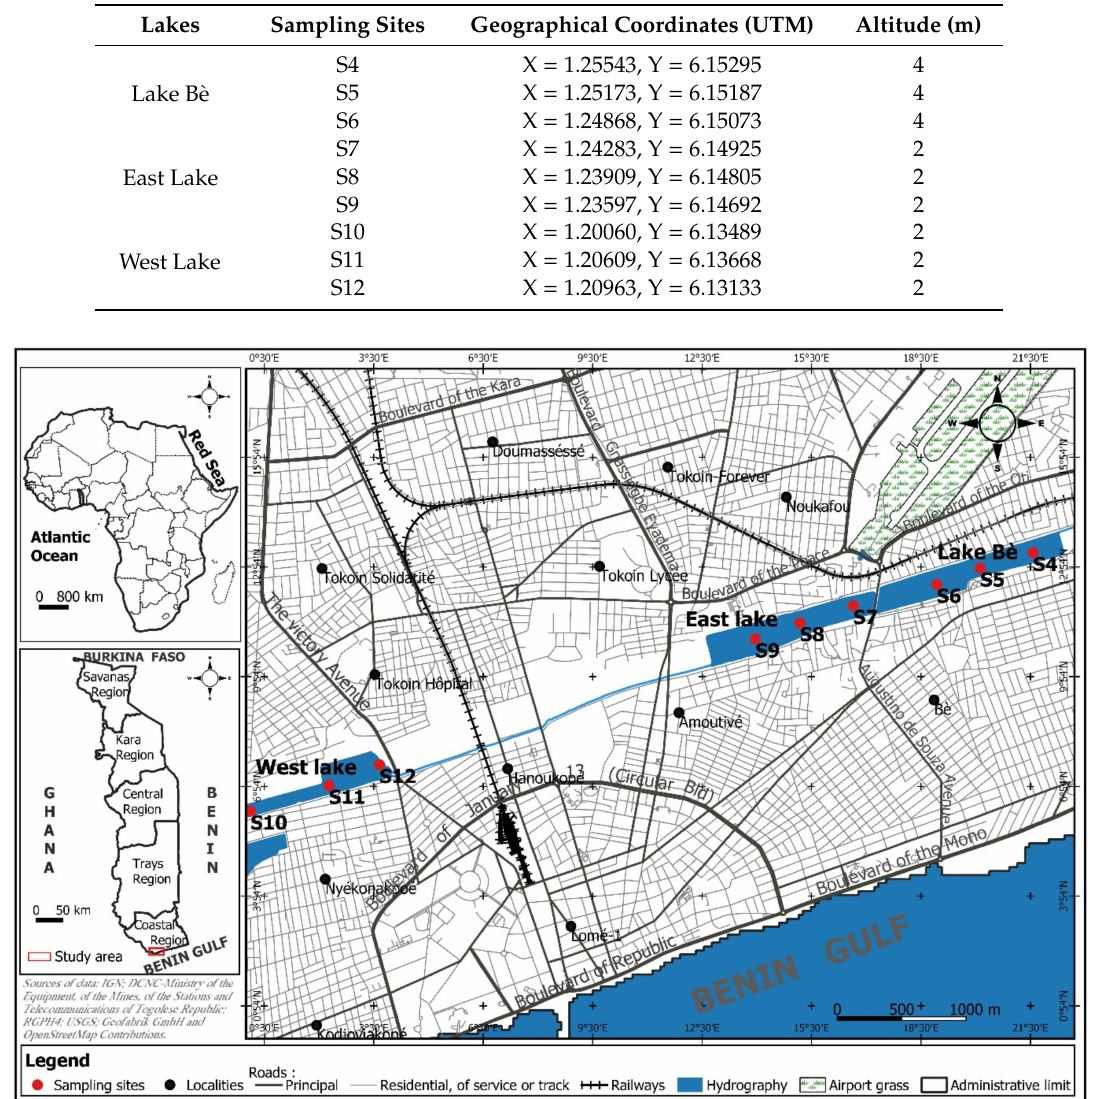
Table 1. Lakes studied and geographic coordinates of the sampling sites.